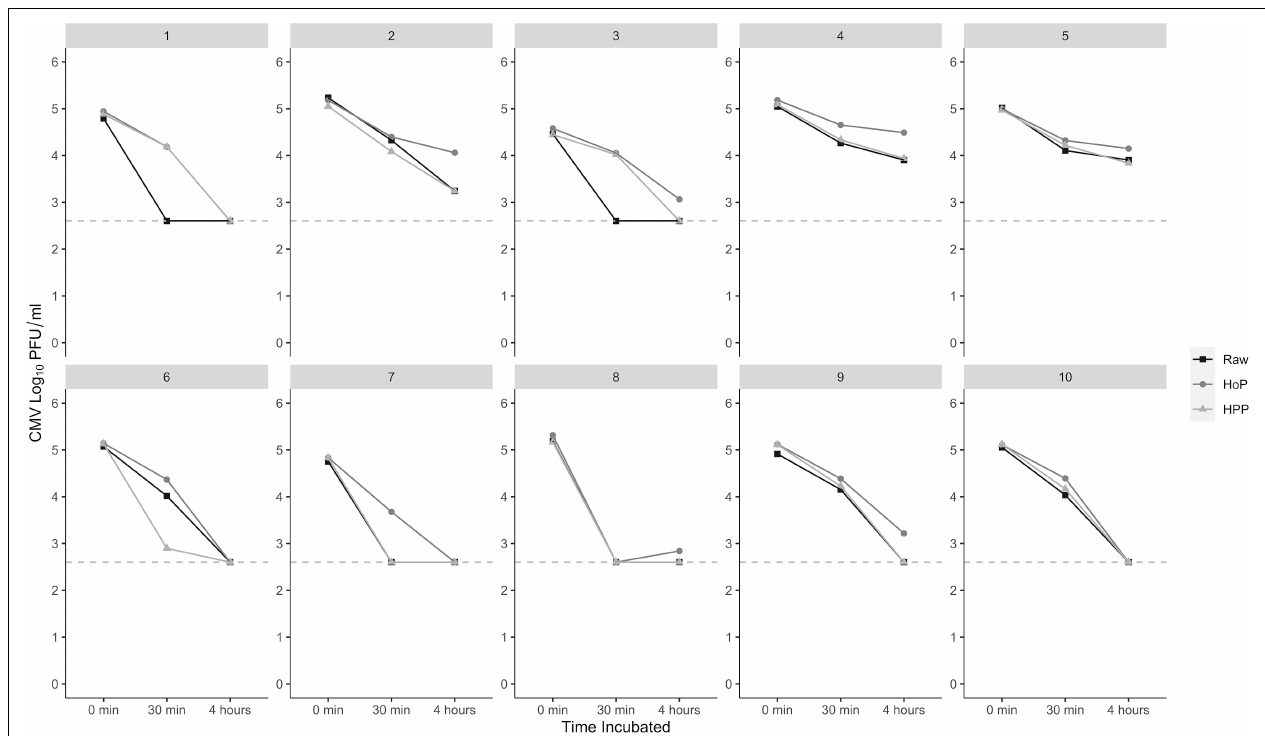
FIGURE 3 | Distribution of anti-CMV activity per pool up to 4 h. Individual donor human milk pools (panels) exhibit varying degrees of reduction in detectable CMV after 30 min and 4 h incubations. Plaque reduction assays were plated in duplicate; the dashed line represents the limit of detection. HoP, Holder pasteurization; HPP, high-pressure